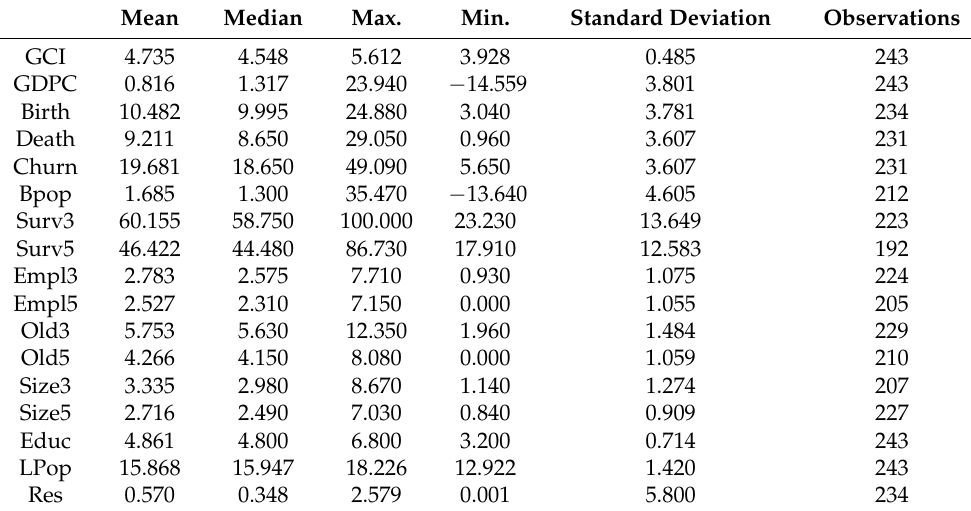
Table 2. Descriptive statistics of the